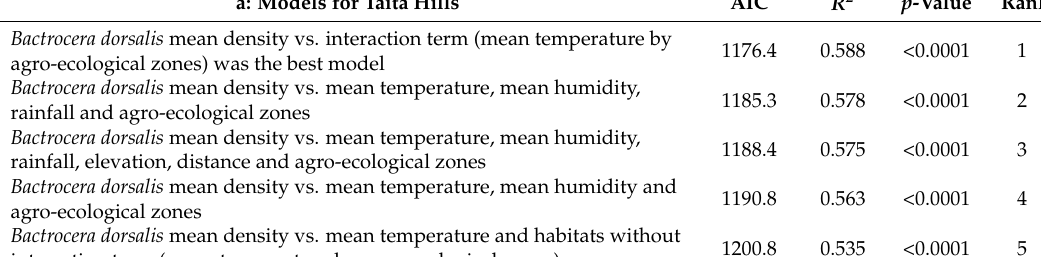
Table 2. Linear mixed effect models explaining change in abundance of Bactrocera dorsalis along agro-ecological zones of Taita Hills in Kenya and Mount Kilimanjaro in Tanzania. a: Models for Taita Hills AIC R 2 p -Value